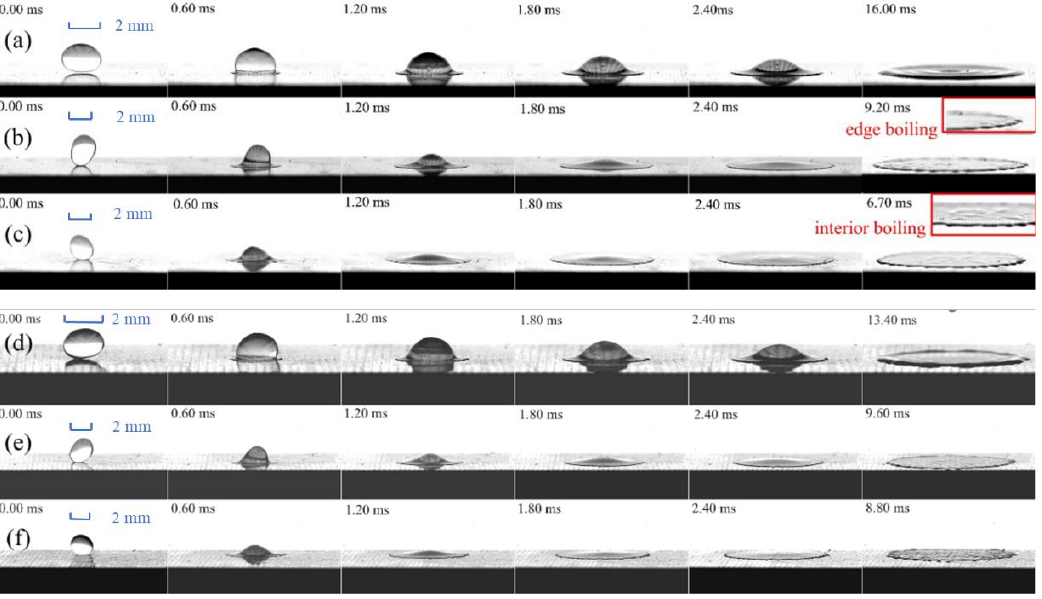
Figure 4. Spreading process of R1336mzz(Z) droplets impinging on low and high roughness surfaces at different We . ( a ) We = 77, ( b ) We = 521 and ( c ) We = 948 ( Ra = 0.8 µm); ( d ) We = 81, ( e ) We = 543 and ( f ) We = 936 ( Ra = 6.3 µm).